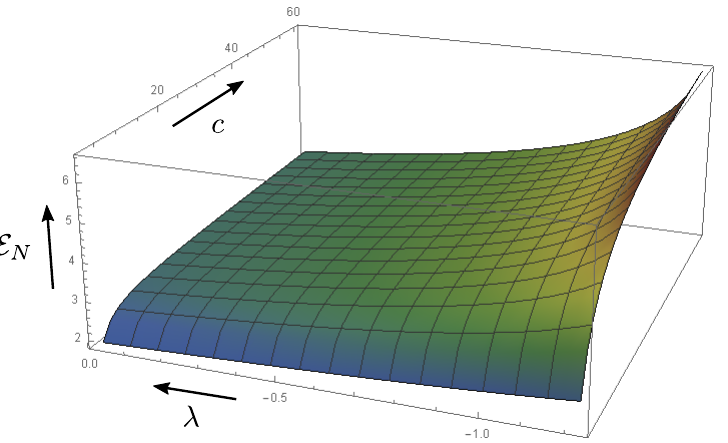
Figure 5: Deformed spectrum for different values of c and λ . We see that the spec- trum increases as we decrease λ and increase c